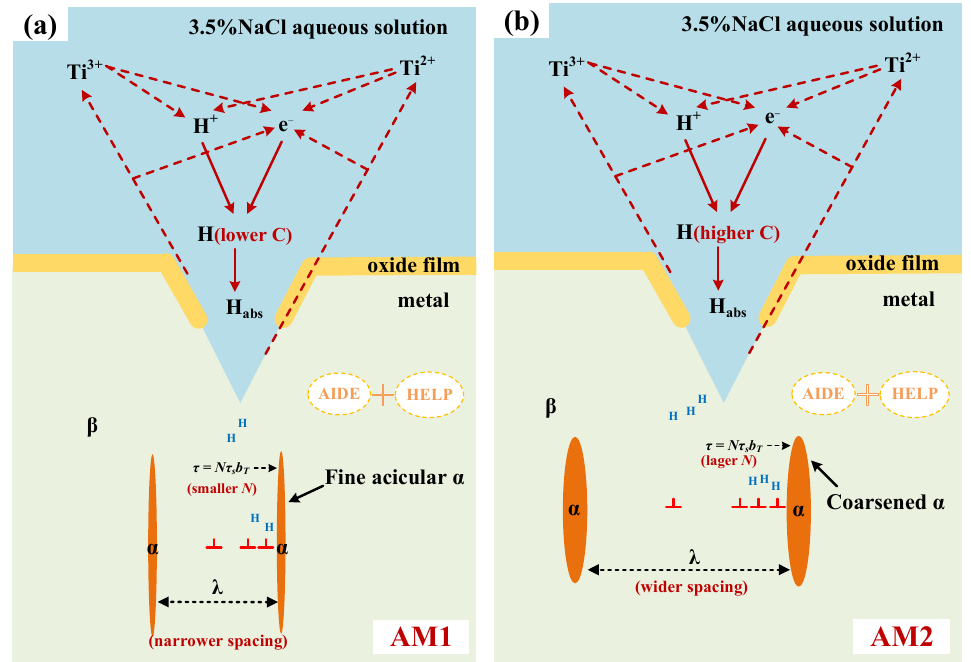
Figure 7. Schematic diagram of effect of secondary α phase on SCC for Ti-6Mo-5V-3Al-2Fe alloy in 3.5% NaCl aqueous solution: ( a ) AM1 alloy; ( b ) AM2 alloy.